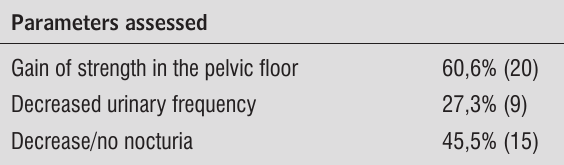
Table 5 - Parameters assessed after the physical therapy treatment.